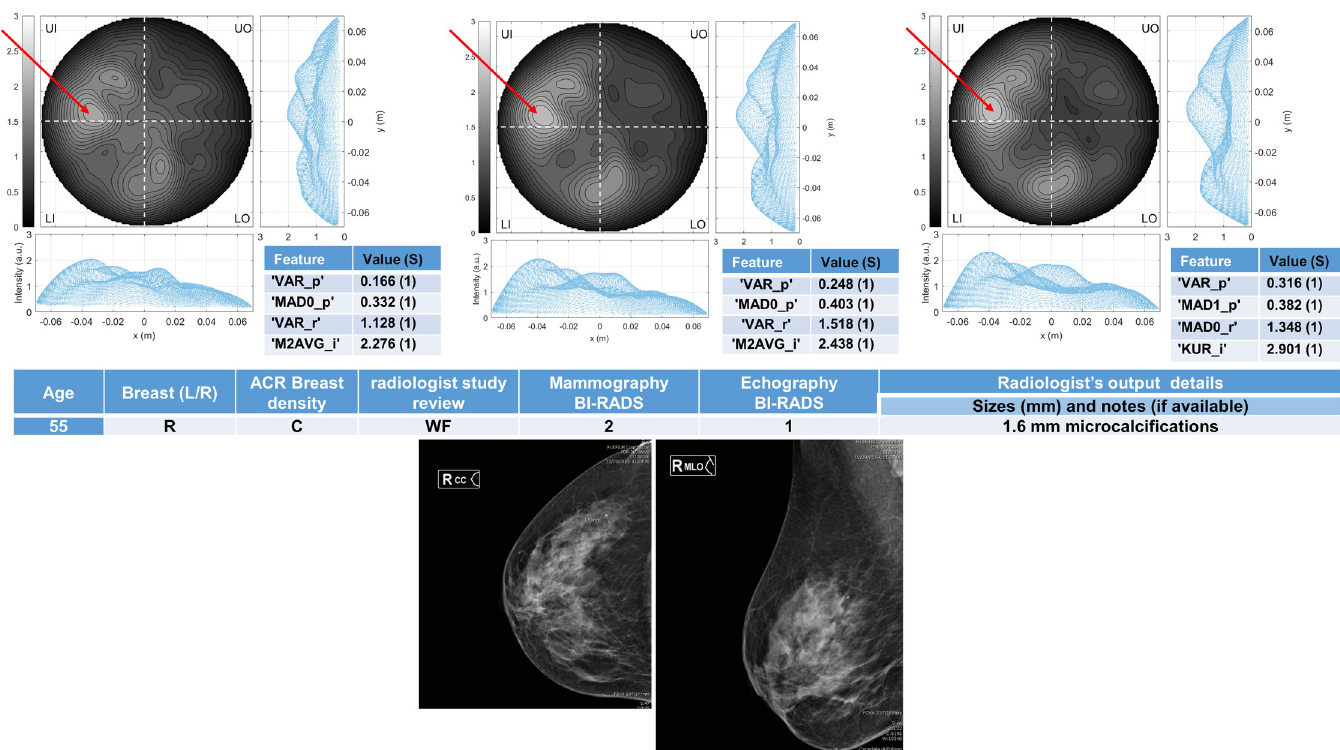
Fig 5. The radiologist study review “WF” for this heterogeneously dense (ACR C) breast has been obtained with the support of mammography images given in the bottom row, giving as output the presence of microcalcifications of 1.6 mm. The Echography BI-RADS is 1 and the Mammography BI-RADS is 2. The final assessment is benign lesion. Microwave images, normalized to unitary average of the intensity, are given in the top row for three different conductivity weighting (from left to right: 0.3 S/m, 0.4 S/m and 0.5 S/m, respectively). X and Y are given in meters; intensity is in arbitrary units. All microwave images show a non-homogeneous behavior, with a main peak indicated by the red arrows. The binary score S (given in the inserted tables) is 1 for the all the features. The proposed rule-of-thumb classifies this breast as positive.